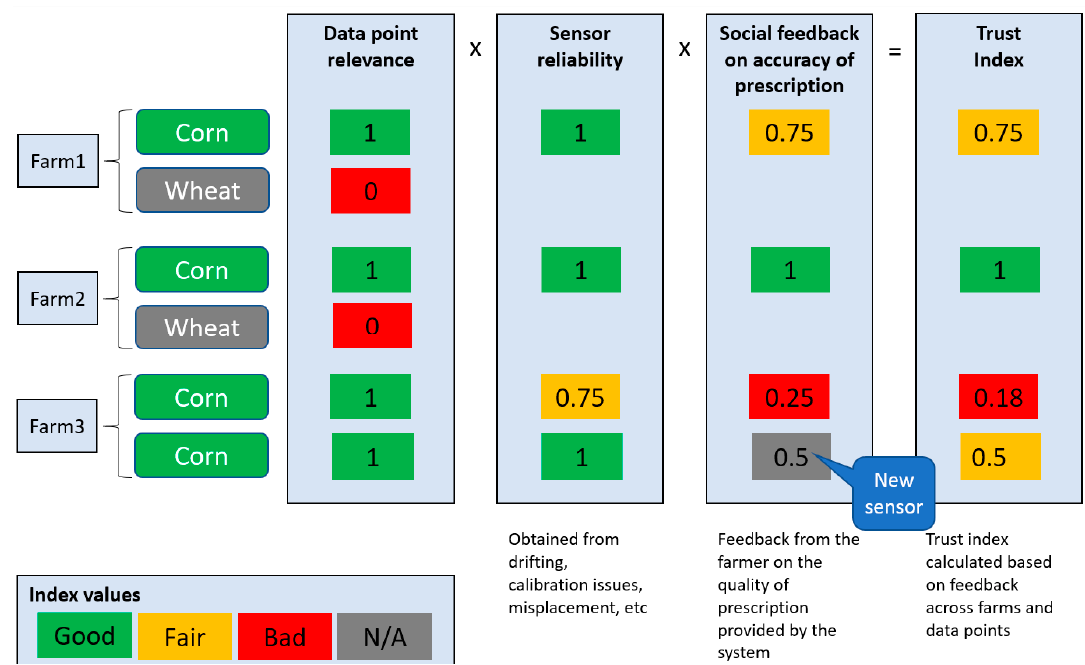
Figure 19. Social Trust Index–sample calculation for same crop type (Corn).